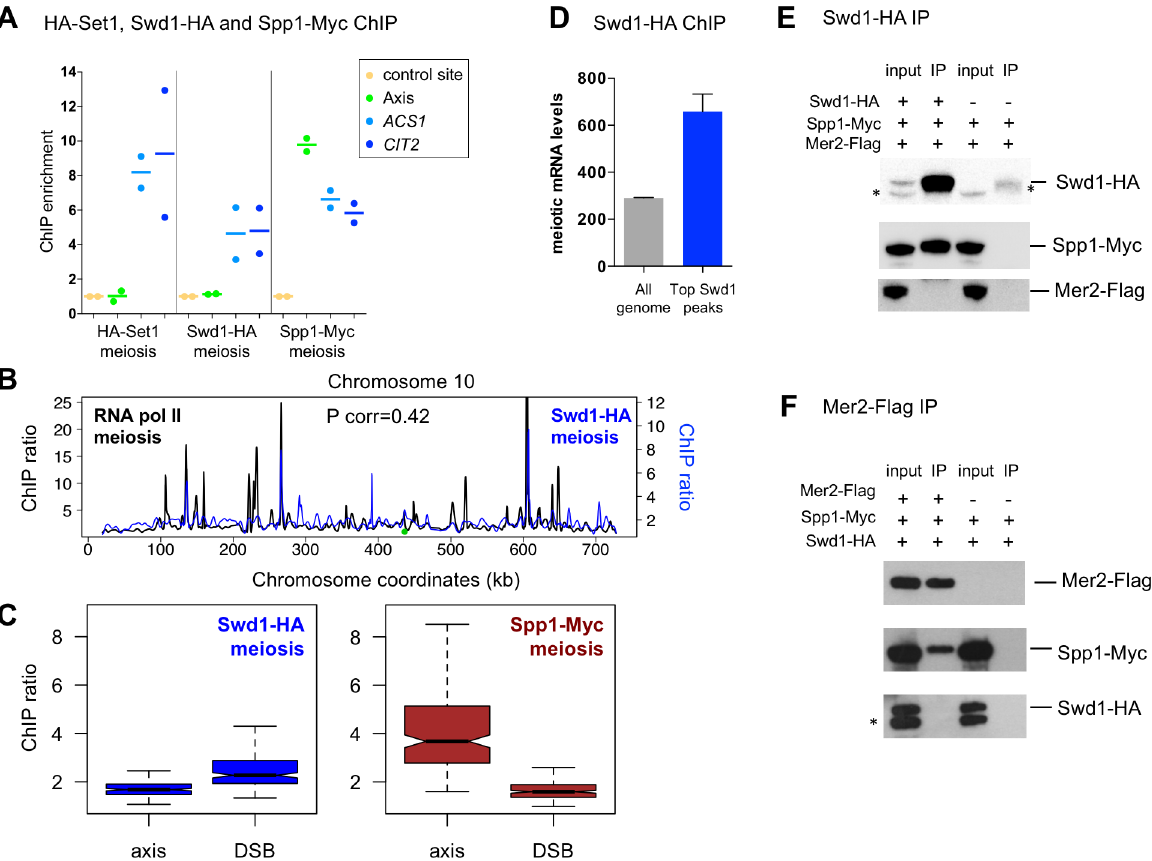
Fig 3. Set1 complex Set1 and Swd1 subunits associate in meiosis with highly transcribed genes, but not with chromosome axis sites. (A) ChIP-qPCR of Set1, Swd1 and Spp1 during meiosis (t = 3 hr) comparing their association with axis and two highly transcribed genes. HA-Set1: VBD1378; Swd1-HA: VBD1399; Spp1-Myc: VBD1187. See also S2 Fig. Each dot represents a biological replicate and the bar indicates the mean. (B) Chromosome profiles of Swd1 and RNA Pol II binding in meiosis (t = 3 hr). RNA Pol II: data are from [18]. Swd1: strain VBD1399 at t = 3 hr. ChIPchip profiles are shown for chromosome 10. Centromere is indicated as a green dot, and ratios are plotted after smoothing with a 1 kb window. (C) ChIPchip signal at the indicated features. The mean signal at the 200 strongest Red1 (axis) and DSB peaks (DSB) is represented, as defined in Methods and in ref [56]. Red1 and DSB data are from previously published studies [23, 59]. Ratios after smoothing with a 2 kb window are plotted. Boxplots indicate median (line), 25th–75th percentile (box) 61.5 times the interquartile range (whiskers). Non-overlapping notches of two boxes are indicative that medians are statistically different. (D) mean mRNA levels at the 100 strongest Swd1 peaks or in the whole genome. mRNA levels are from SK1 diploid meiotic cells at t = 4 hr [58]. Error bars: S.E.M. (E) Co-immunoprecipitation by the core Set1 complex Swd1 protein from cells at 3.5 hr in meiosis analyzed by western blot using anti-HA, anti-Myc or anti-Flag antibody as indicated. Swd1-HA Spp1-Myc Mer2-Flag: VBD1401; Spp1-Myc Mer2-Flag: VBD1395. IP: immunoprecipitation. The asterisk indicates non-specific cross-hybridizing band. (F) Co-immunoprecipitation by the DSB protein Mer2 from cells at 3.5 hr in meiosis. Same antibodies as in (E). Swd1-HA Spp1-Myc Mer2-Flag: VBD1401; Spp1-Myc Swd1-HA: VBD1400. The asterisks indicates non-specific cross-hybridizing bands unrelated to Swd1-HA.